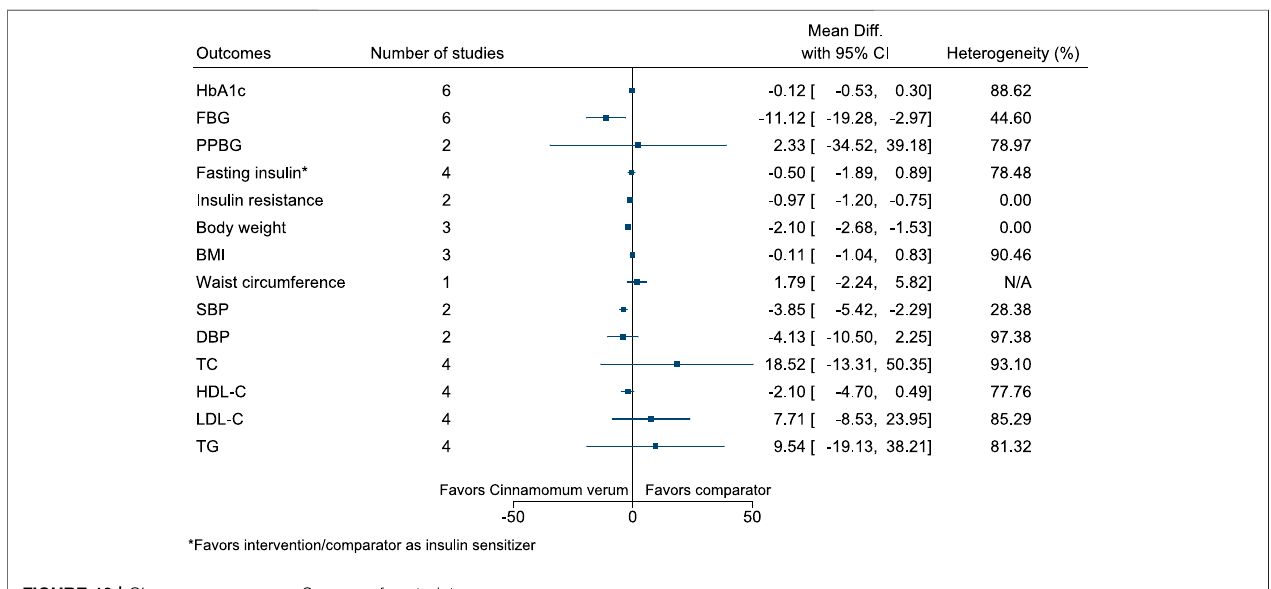
FIGURE 10 | Cinnamomum verum — Summary forest plot.